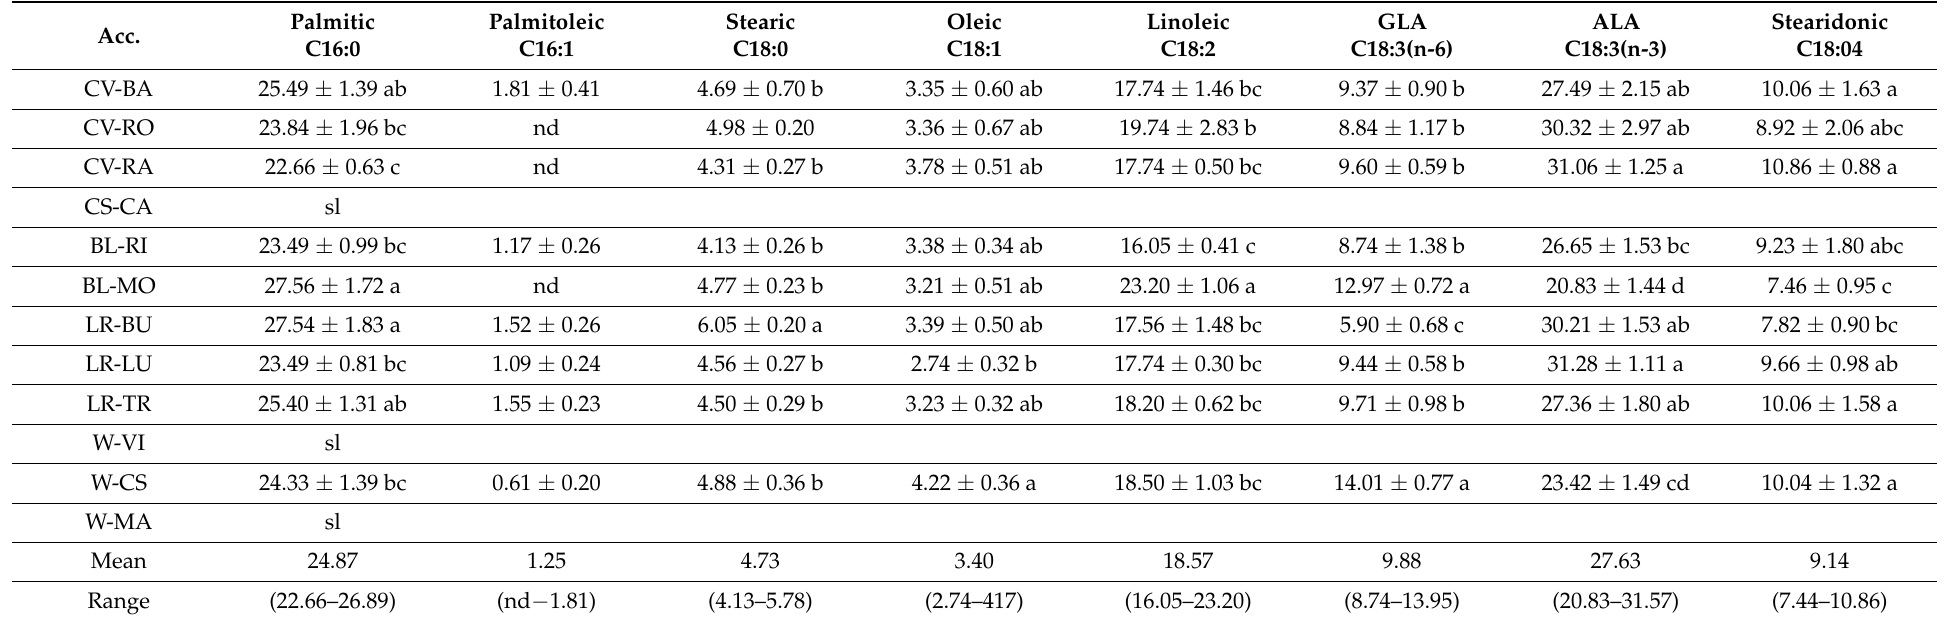
Table 3. Fatty acid composition, expressed in percentage of total fatty acids, of petioles of 12 borage accessions sampled at 150 days after sowing (Mean ± SD (n = 6)).